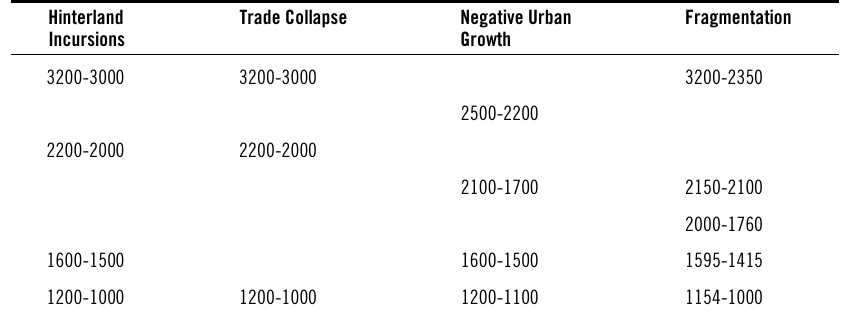
Table 5 – The Timing of Selected Mesopotamian